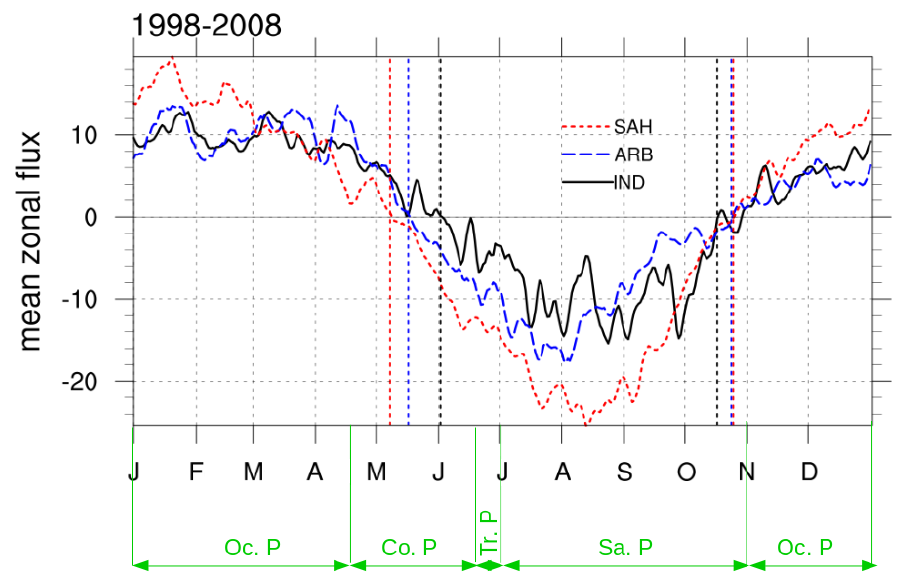
Figure 9. Averaged zonal flux (in kg · (m · s) − 1 , 1998–2008) between 500 and 300 hPa, in India (black), Arabia (blue), and Sahel (red), represented from January to December. Data have been filtered using a 5 day moving average. In green, the different phases of the annual cycle of the West African monsoon are in green: Oc. P: Oceanic Phase; Co. P: Coastal Phase; Tr. P: Transitional Phase; Sa. P: Sahelian Phase.